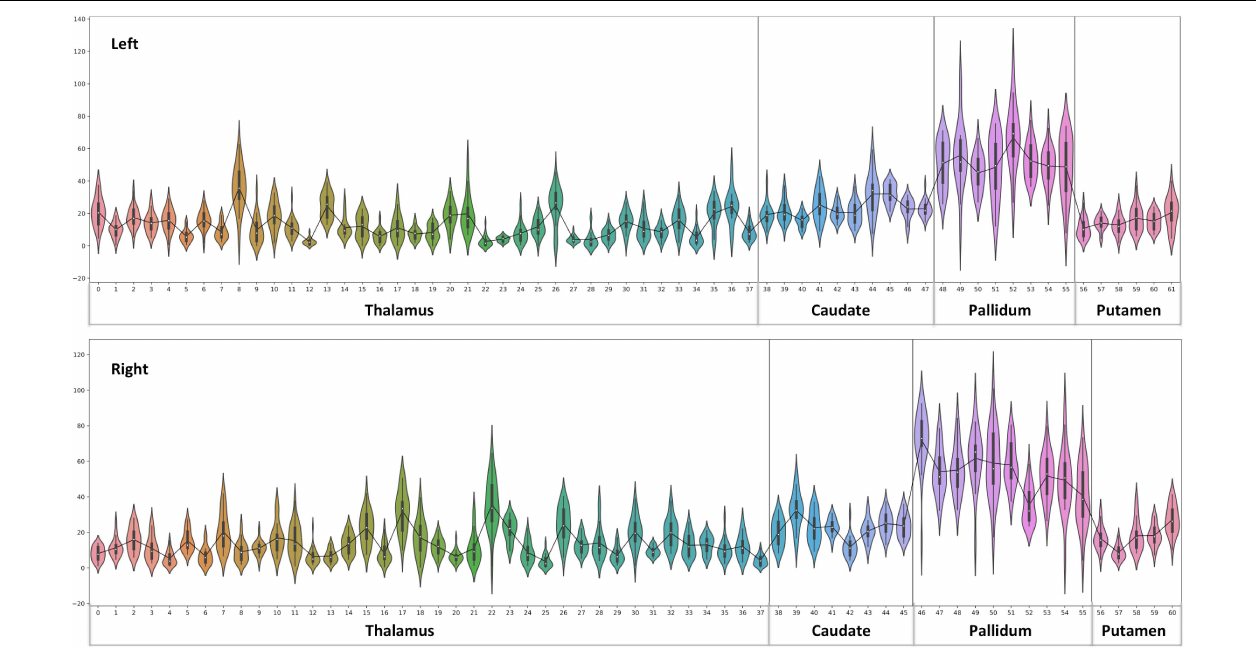
FIGURE 10 | Violin plot of paramagnetic sources (iron): the violin plot highlights only the mean of each parcel. The black line plot shows only the mean values of all parcels in all subjects. First, note the overall lower values for the Th, caudate, and putamen contrast to consistent higher pallidum parcels values. Second, the violin plot reveals inter-individual